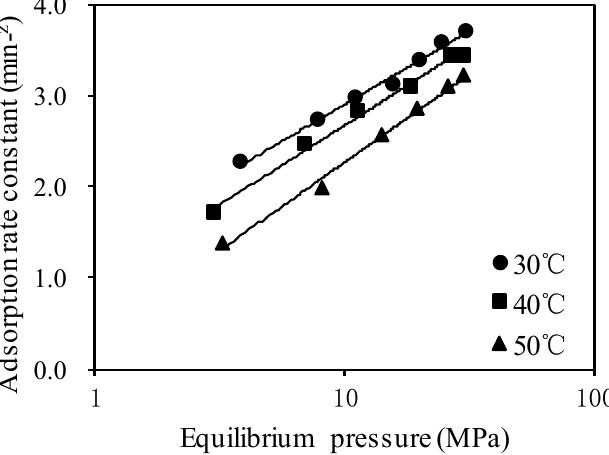
Figure 11. Adsorption amount versus equilibrium pressure at different temperature.